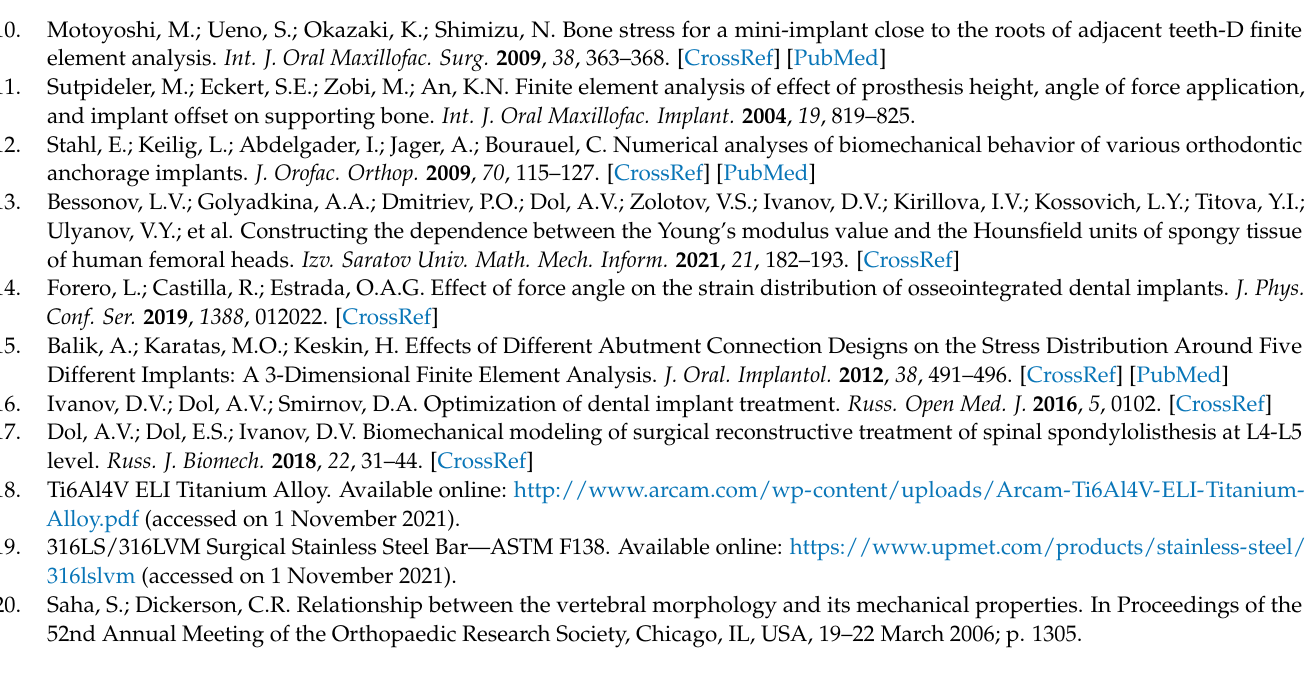
316LS/316LVM Surgical Stainless Steel Bar—ASTM F138. Available online: https://www.upmet.com/products/stainless-steel/ 316lslvm (accessed on 1 November